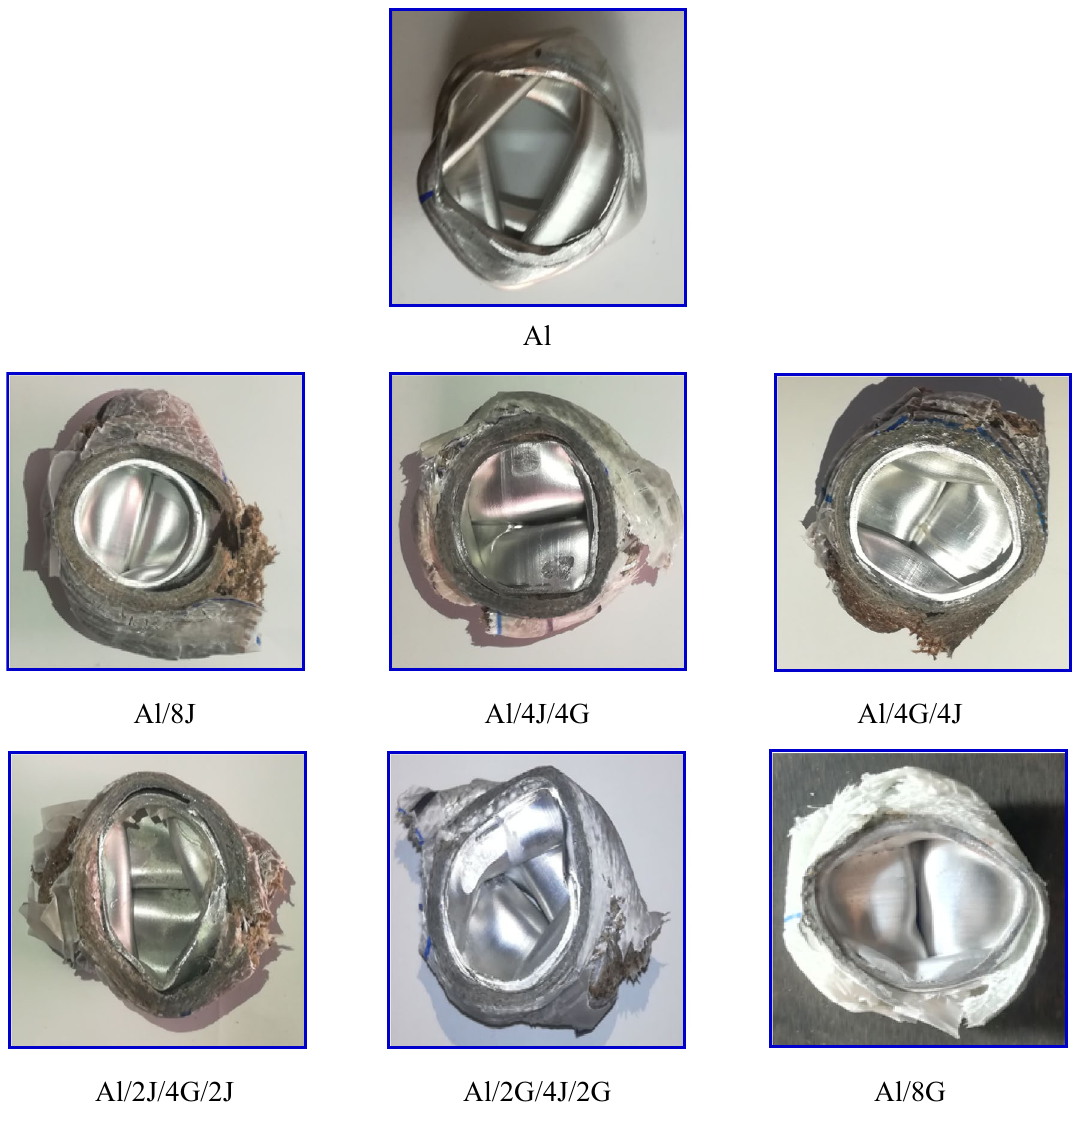
Figure 16. Top views for failed